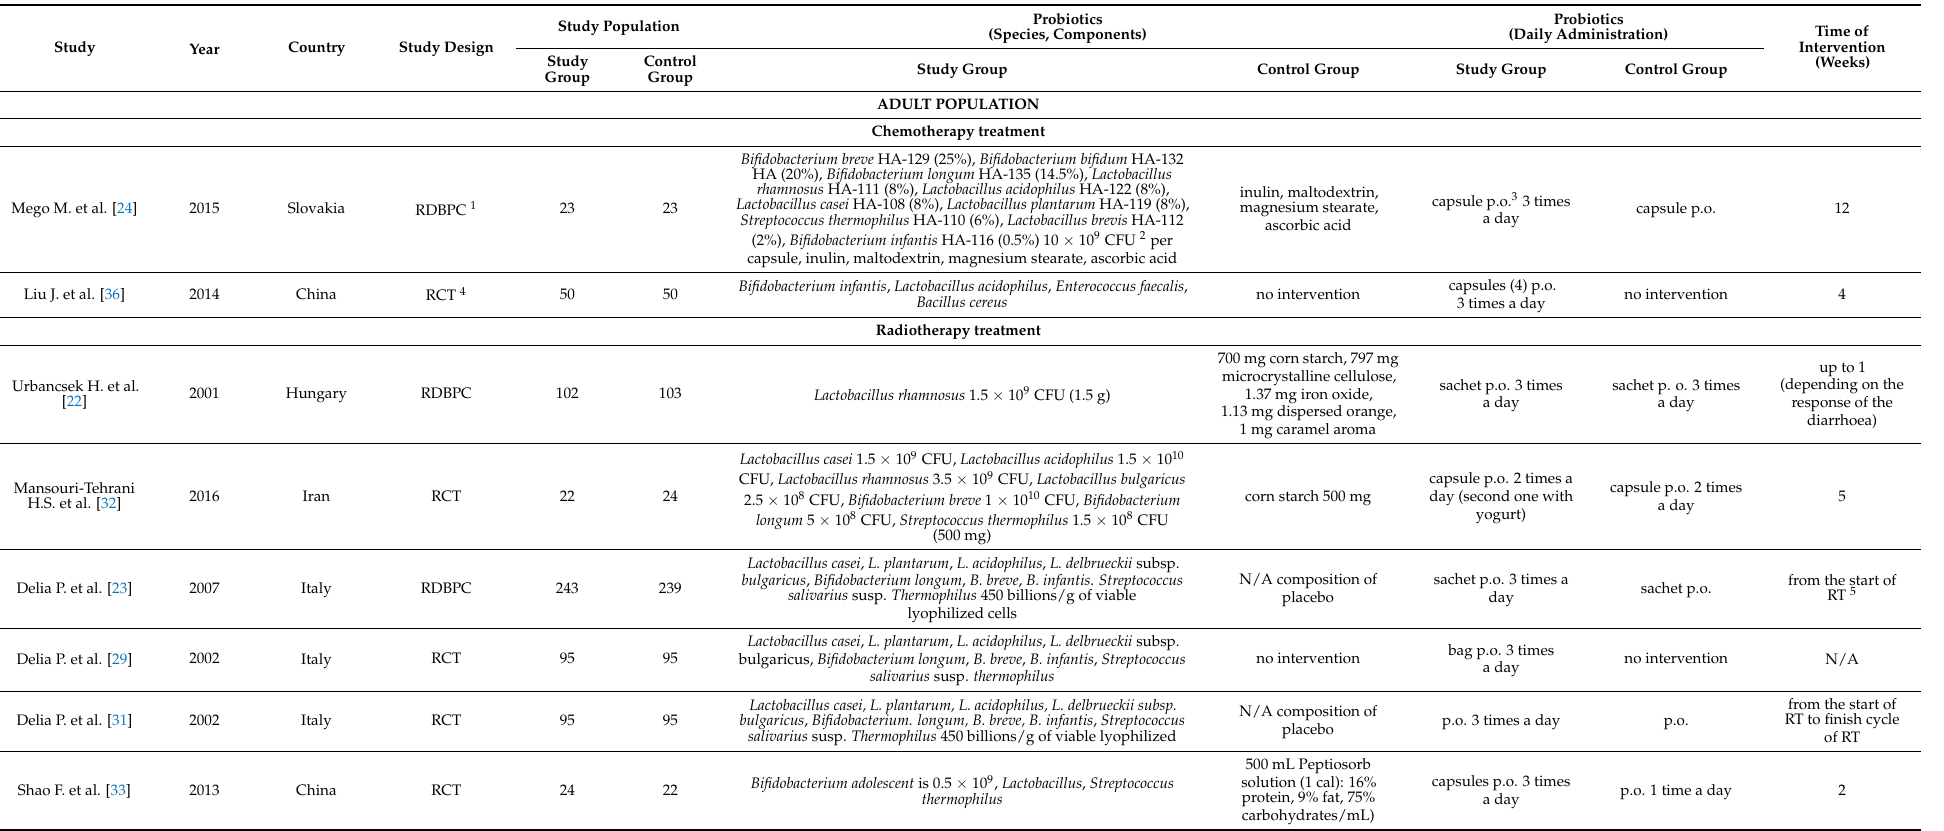
Table 1. Characteristics of the included studies ( n =